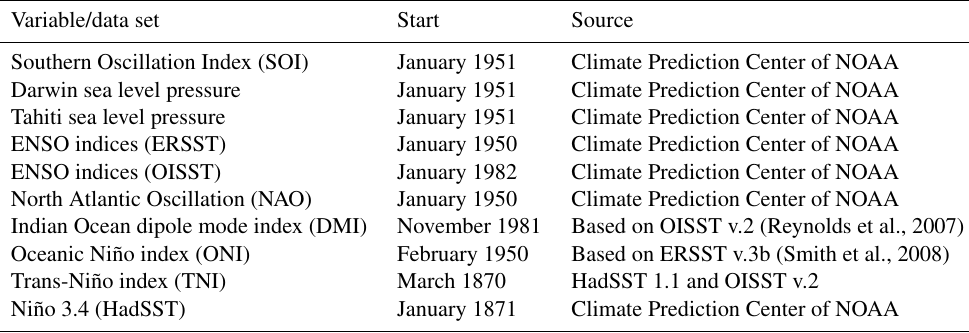
Table 2. Climate indices used as potential